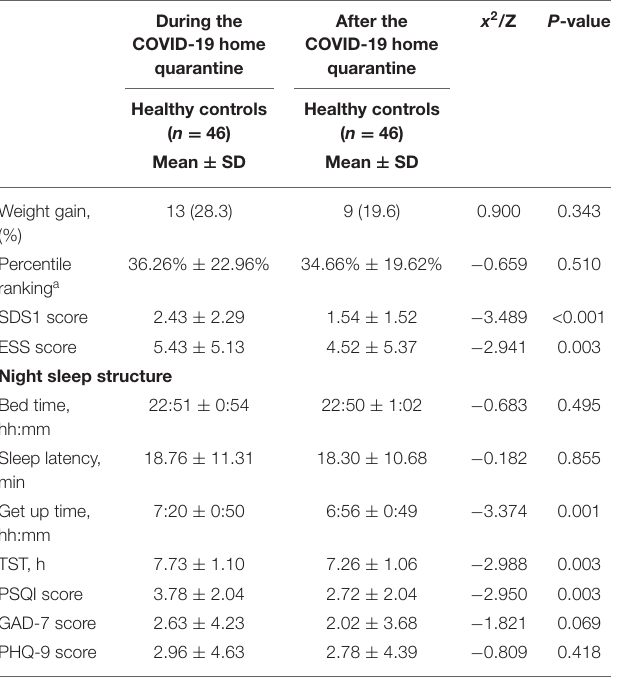
TABLE 3 | The sleep pattern rather than the school performance was affected by the COVID-19 home quarantine in healthy comtrols. During the COVID-19